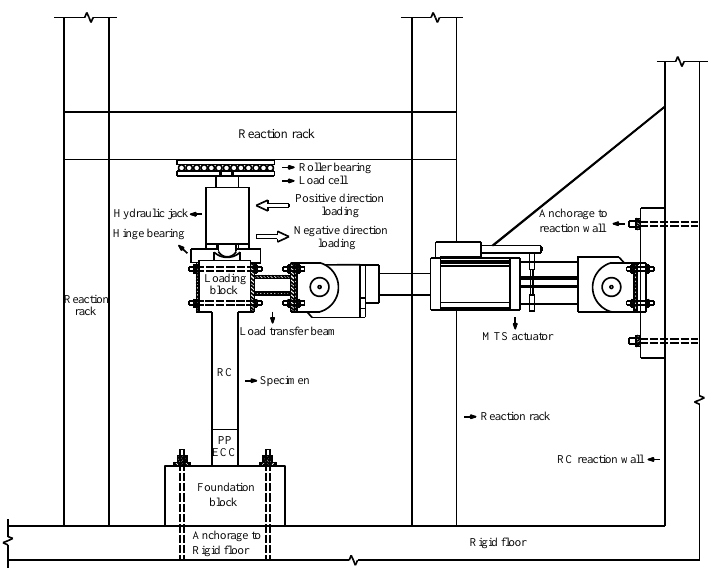
Figure 3. Schematic diagram of the test setup in the study.